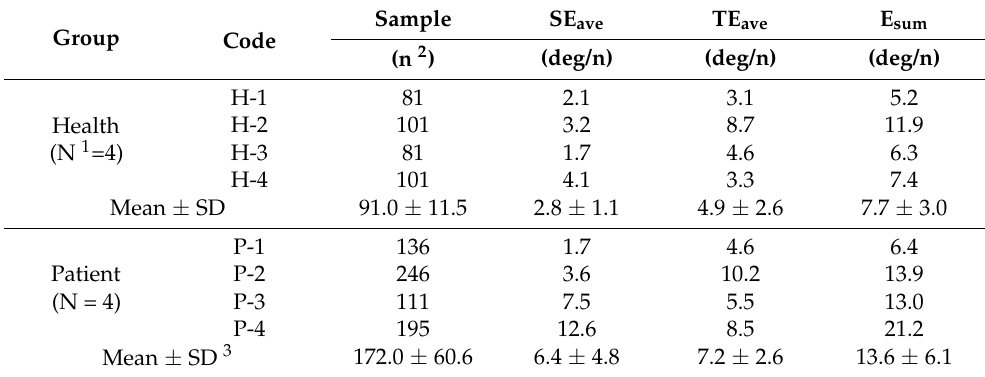
Table 2. EA error in both groups.